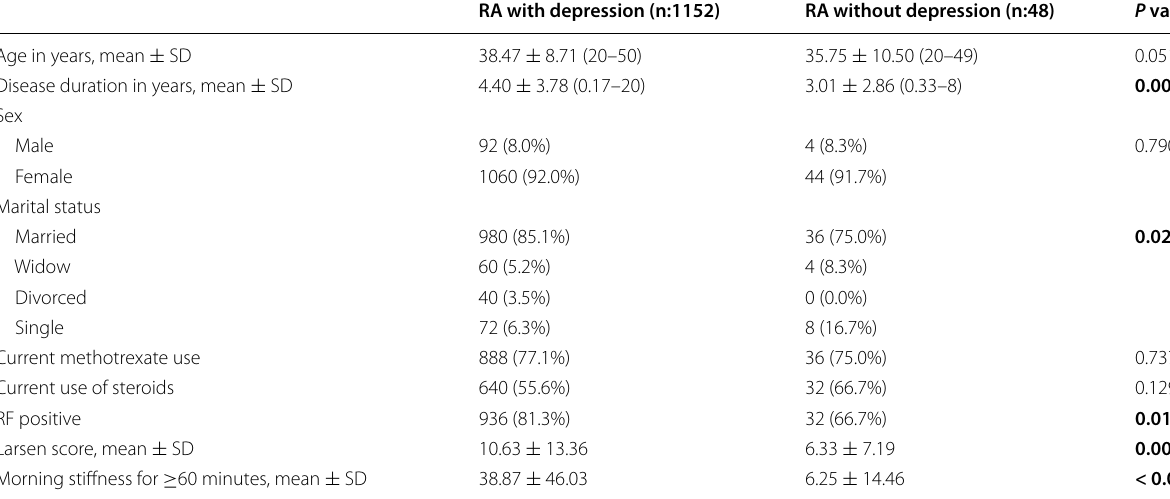
Table 1 Demographic and clinical characteristics of RA patients with and without depression RA with depression